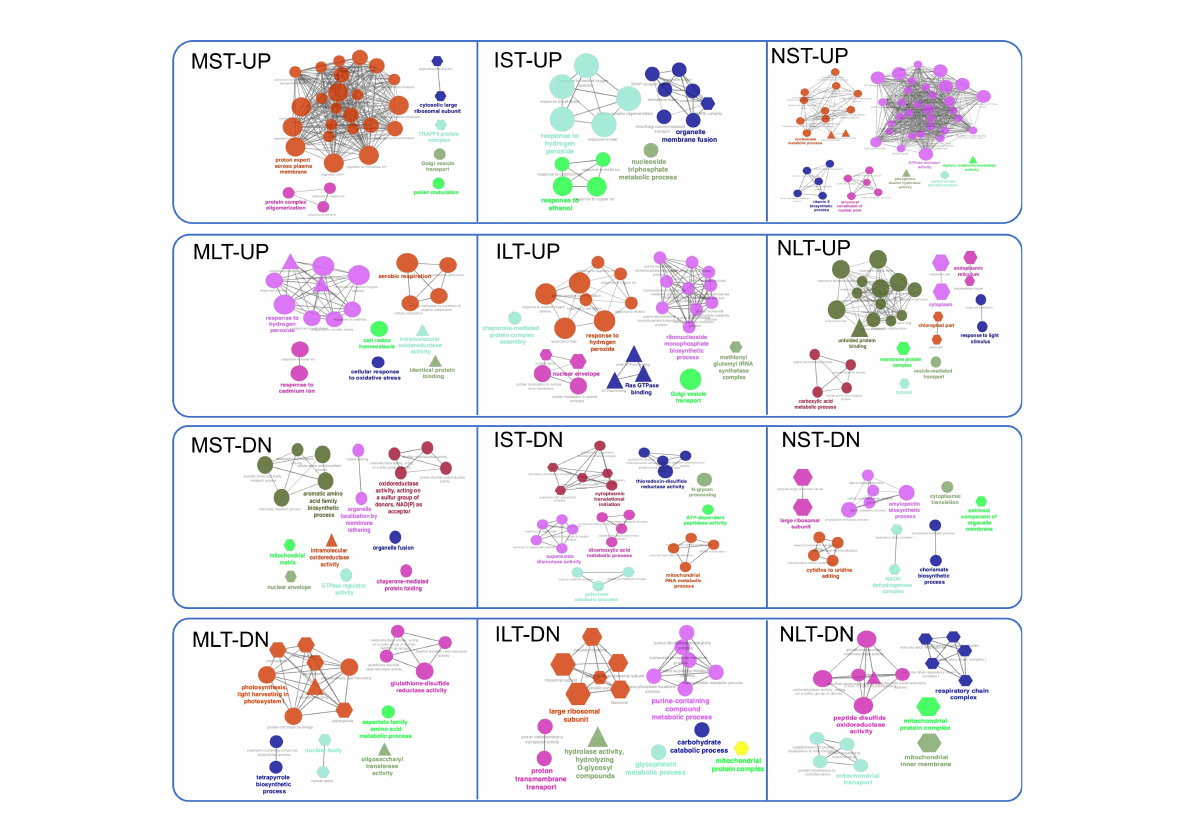
FIGURE 6 Gene Ontology (GO) network analysis of differentially abundant proteins. GO term enrichment network for the up-and down-regulated proteins in Moroberekan, IR64 and N22 short-term and long-term heat stress conditions was created using Cytoscape software (Version 3.7.1) with ClueGO (Version 2.5.4) plug-in. The colored circles represent the biological function, triangles represent the molecular function, and hexagons represent the cellular components hierarchically. ST, Short term HS; LT, Long, term heat stress; MC, Moroberekan control; MST, Moroberekan ST_HS; MLT, Moroberekan LT_HS; IC, IR64 control; IST, IR64 ST_HS; ILT, IR64 LT_HS; NC, N22 control; NST, N22 ST_HS; NLT, N22 LT_HS; UP, upregulated; DN,